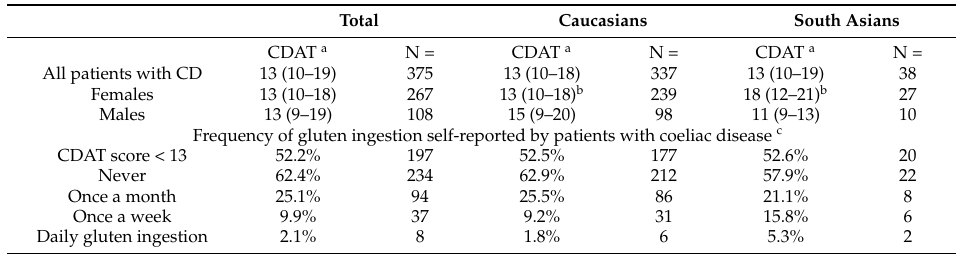
Table 1. Gluten free dietary adherence CDAT scores a and percentage who self-reported the frequency of consuming